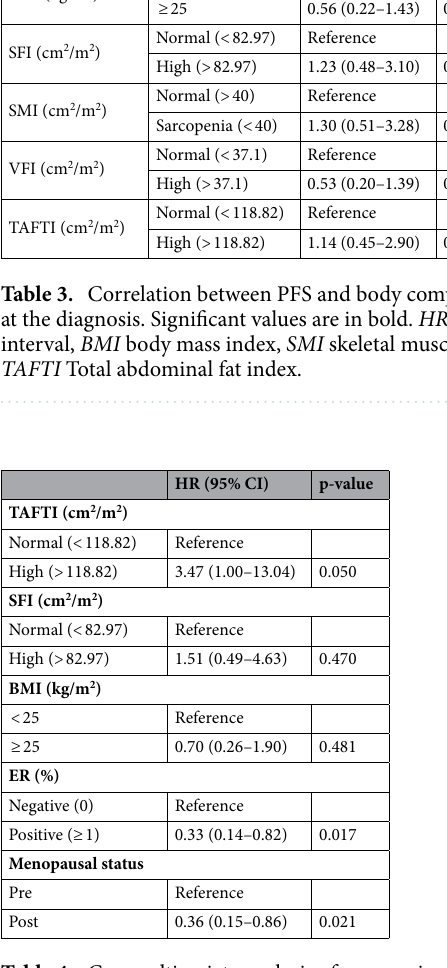
Table 4. Cox multivariate analysis of progression-free survival (PFS). TAFTI Total abdominal fat index, SFI Subcutaneous fat Index, BMI Body mass index, ER Estrogen